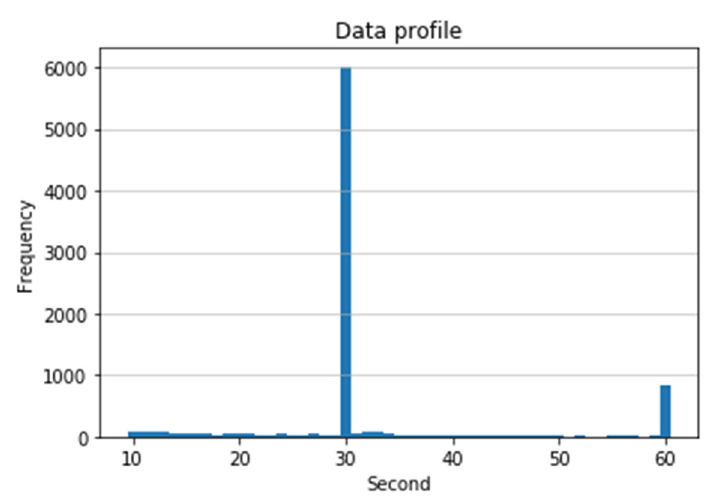
Figure 3. Data length histogram distribution.